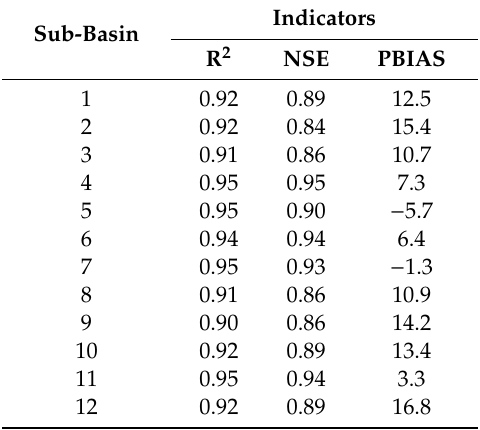
Table 3. Performance of the Soil and Water Assessment Tool (SWAT)-2U model to simulate the monthly evapotranspiration (ET). NSE: Nash-Sutcliff efficiency; PBIAS: percent bias; R 2 : coefficient of determination.